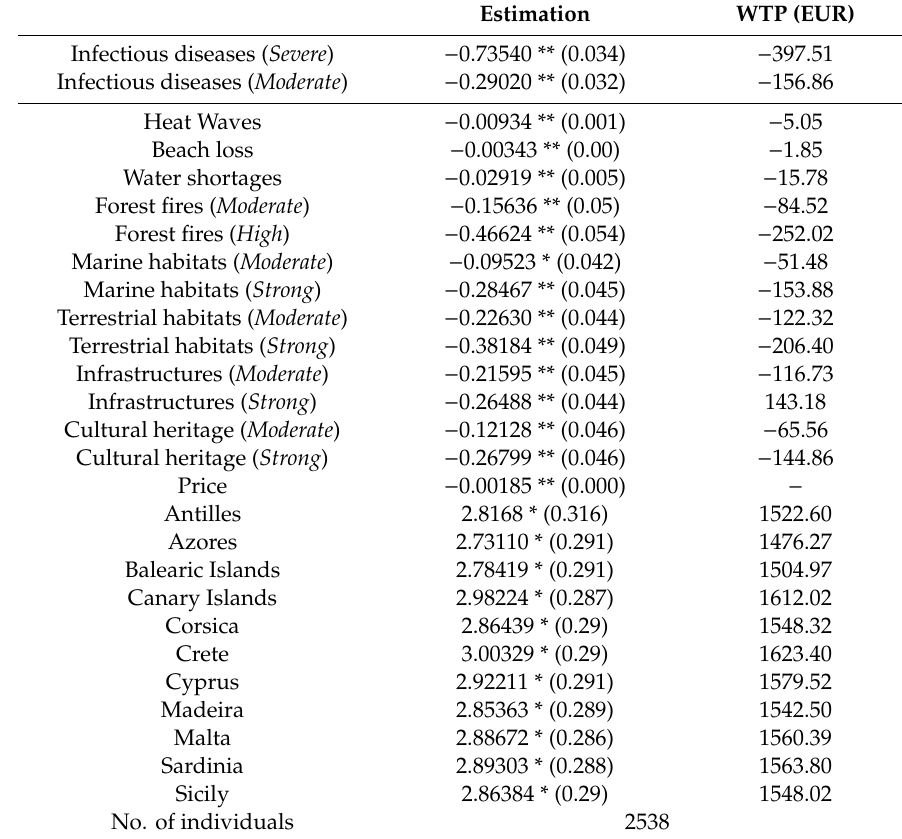
Table 4. Estimation results for tourists’ willingness-to-pay (WTP) for visiting island destinations under climate change (CC)